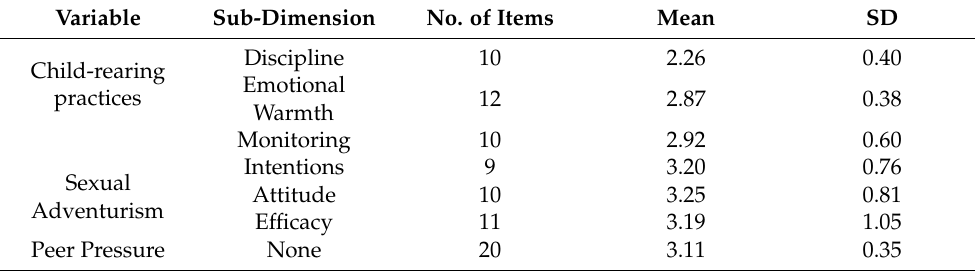
Table 1. Descriptive statistics of the variables.